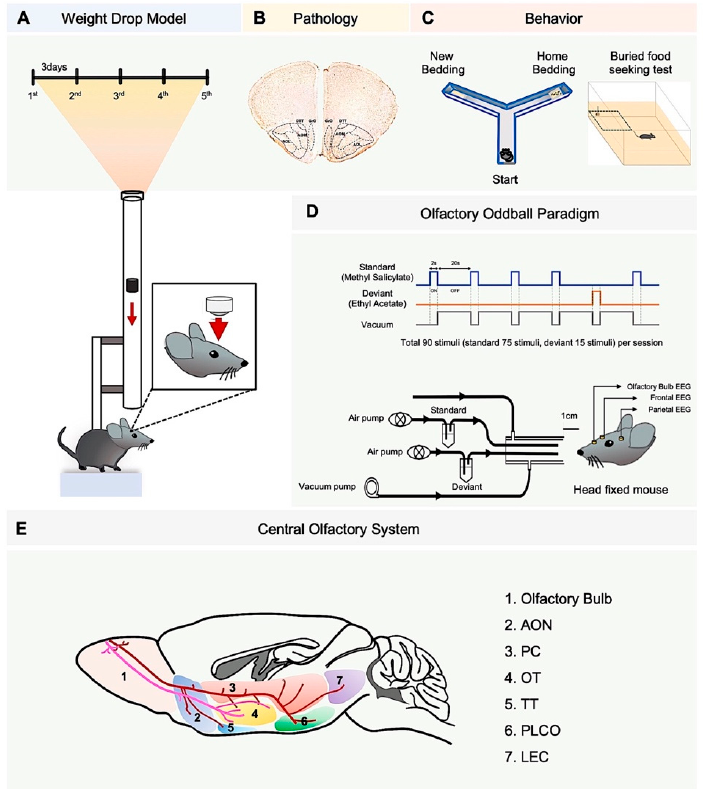
Figure 1. Weight ‐ drop model of traumatic brain injury (TBI) and experiment workflows. ( A ) Mice experienced 5 weight ‐ drop ‐ induced TBI events. ( B ) Brain tissue was analyzed from postmortem WT mice ( N = 5 Control, N = 5 TBI) within 5 days after 5th TBI. ( C ) Living WT mice underwent Y maze behavioral test ( N = 5 Control, N = 6 TBI) and buried ‐ food ‐ seeking test ( N = 6 Control, N = 6 TBI). ( D ) A simplified diagram of the olfactometer used to deliver the two odor stimuli. Schematic overview of the two ‐ odor olfactory oddball paradigm ( upper panel ). Odor ‐ evoked electrophysiology data of Thy1 mice was collected by using a two ‐ odor olfactory oddball paradigm ( N = 4 Control, N = 10 TBI) ( lower panel ). ( E ) A schematic diagram of the central olfactory system. Axonal projections from the olfactory bulb reach a number of areas, including the anterior olfactory nucleus (AON), pyriform cortex (PC), olfactory tubercle (OT), tenia tecta (TT), lateral entorhinal cortex (LEC), and cortical amygdala (PLCo).